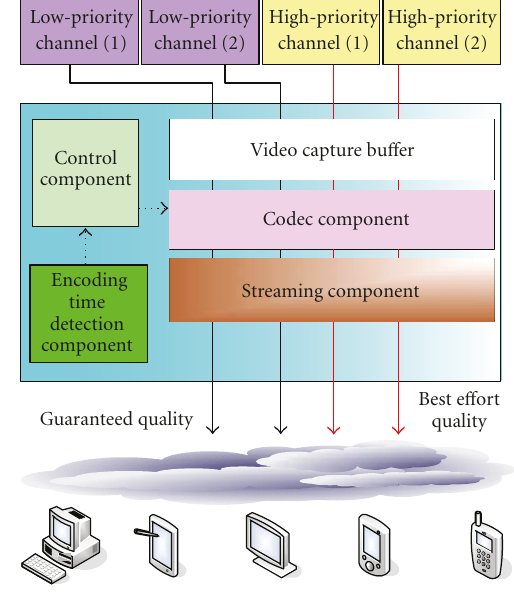
Figure 1: Complexity-aware live streaming server